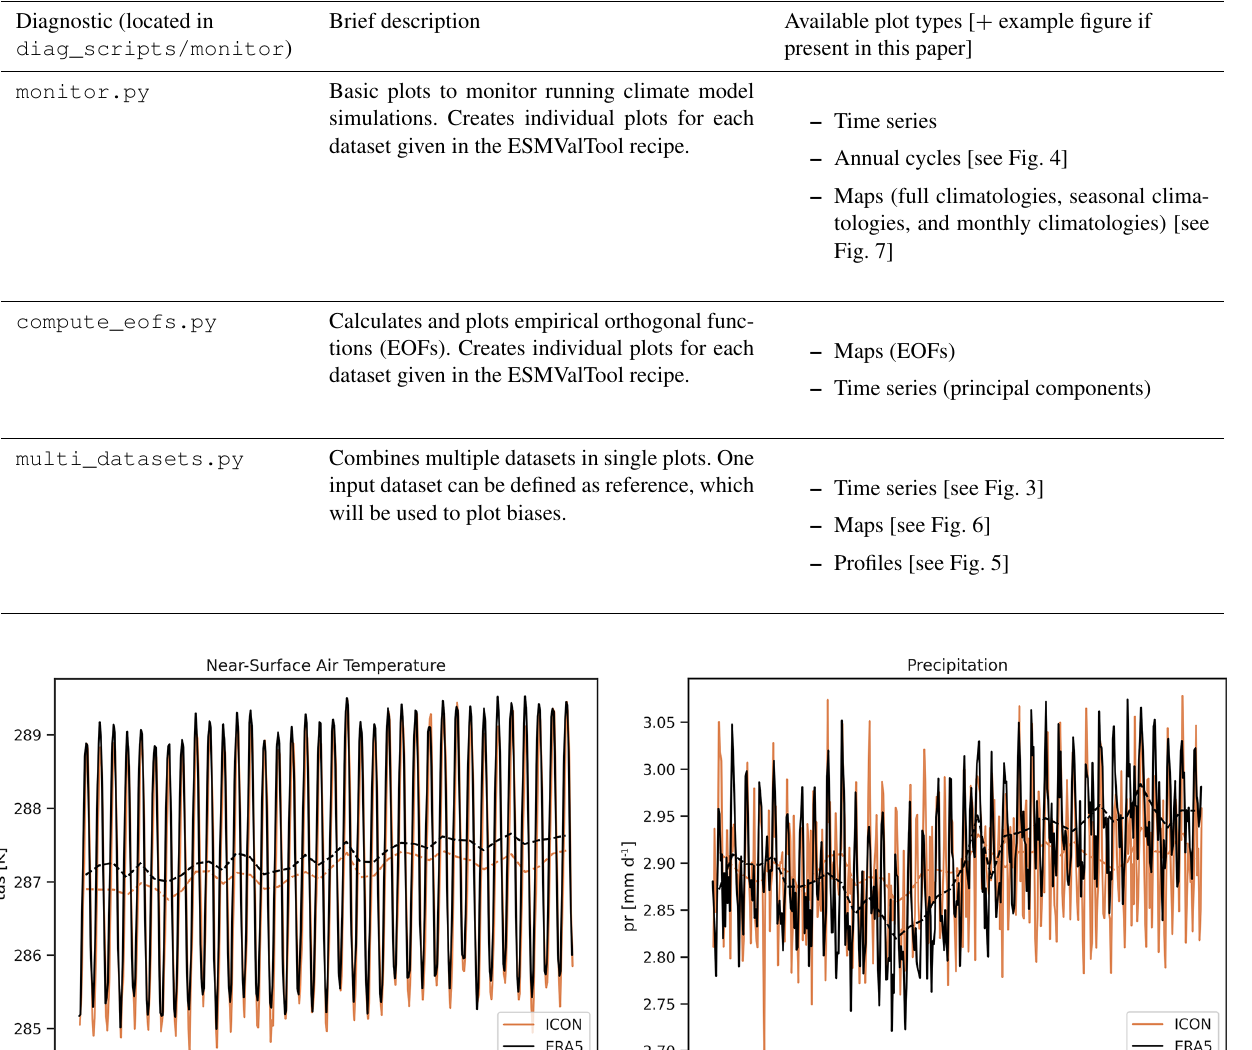
Table 1. Overview of the general-purpose monitoring diagnostics implemented in ESMValTool. All diagnostics can handle arbitrary variables from arbitrary datasets.